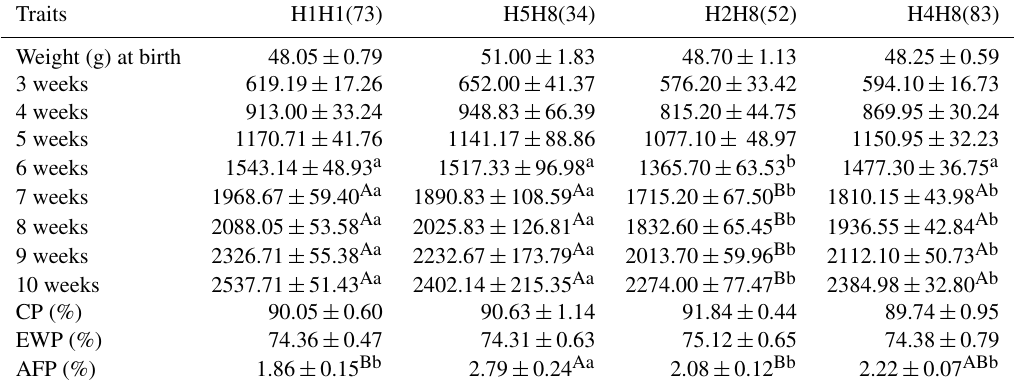
Table 3. Least square means ( ± SE) of the traits, by diplotype, of the duck VLDLR gene. Traits H1H1(73)